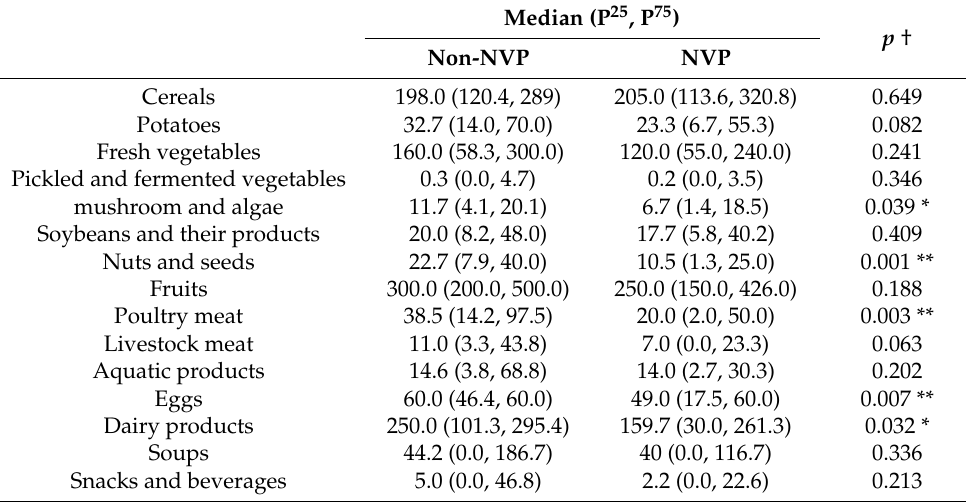
Table 5. Comparison of average daily food intake of pregnant women with and without nau- sea/vomiting in early pregnancy